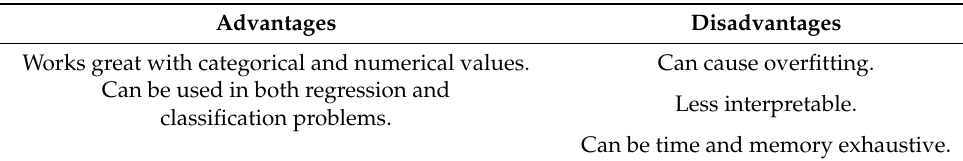
Table 4. Advantages and disadvantages of GBM.